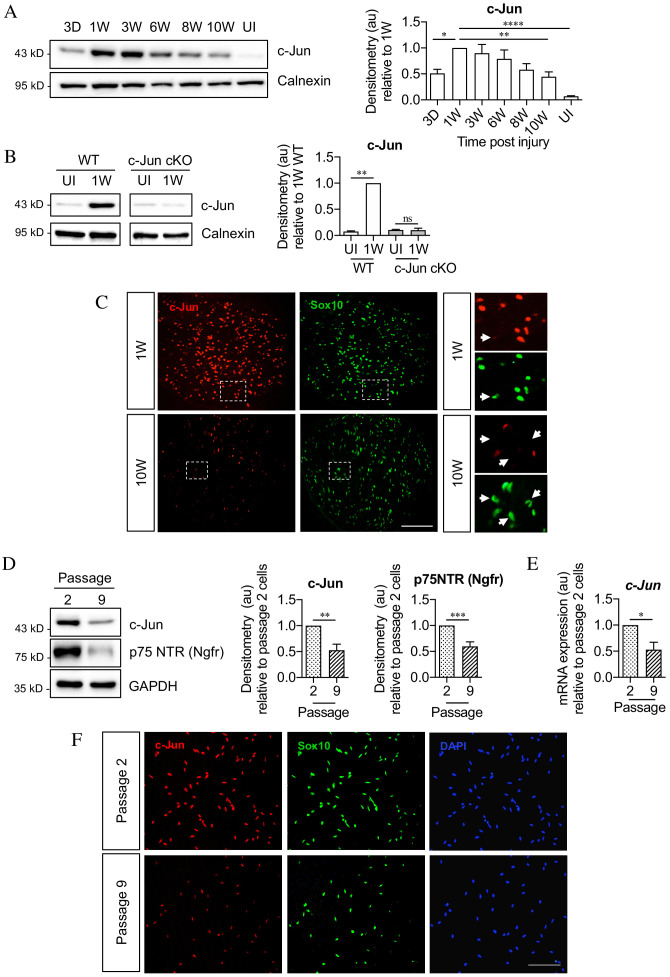
c-Jun declines in the distal nerve stump during chronic denervation and long-term culture.(A) Representative Western blot of c-Jun in WT uninjured (UI) nerves and distal stumps following 3 days and 1, 3, 6, 8, and 10 weeks of denervation. The graph quantitates the results, showing an initial increase followed by a decline in c-Jun levels. Data normalized to 1 week post-injury. One-way ANOVA with Dunnett’s multiple comparisons test; *p<0.05, **p<0.005, ****p<0.0001. n = 5. (B) Representative western blot comparing c-Jun expression 1 week after injury in WT and c-Jun cKO mice. The graph quantitates the results, showing upregulation of c-Jun in WT nerves but not in c-Jun cKO nerves, demonstrating that the c-Jun upregulation after injury is Schwann cell specific. Data normalized to WT 1 week post-injury. Two-way ANOVA with Sidak’s multiple comparison test; ****p<0.0001. n = 5. (C) Representative immunofluorescence images of c-Jun/Sox10 double labeling in transverse sections of the distal stumps 1 and 10 weeks after cut. Boxed areas shown at higher magnification in right hand panels. Note loss of c-Jun protein from Schwann cell nuclei at 10 weeks (arrows). (D) Representative Western blot of c-Jun and p75NTR in Schwann cell cultures after two or nine passages. The results are quantitated in the graphs, showing decline in c-Jun and p75NTR with time in vitro. Data normalized to passage 2. Unpaired Student’s t-test; **p=0.0023, ***p=0.0007. n = 6 for c-Jun, n = 7 for p75NTR. (E) qPCR analysis showing reduction in c-Jun mRNA in Schwann cultures following nine passages. Data normalized to passage 2. Unpaired Student’s t-test; *p=0.0299. n = 3. (F) c-Jun/Sox10 double labeling with nuclear marker DAPI after two or nine passages. Note decline of nuclear c-Jun in passage 9 cells. All numerical data represent means ± SEM.